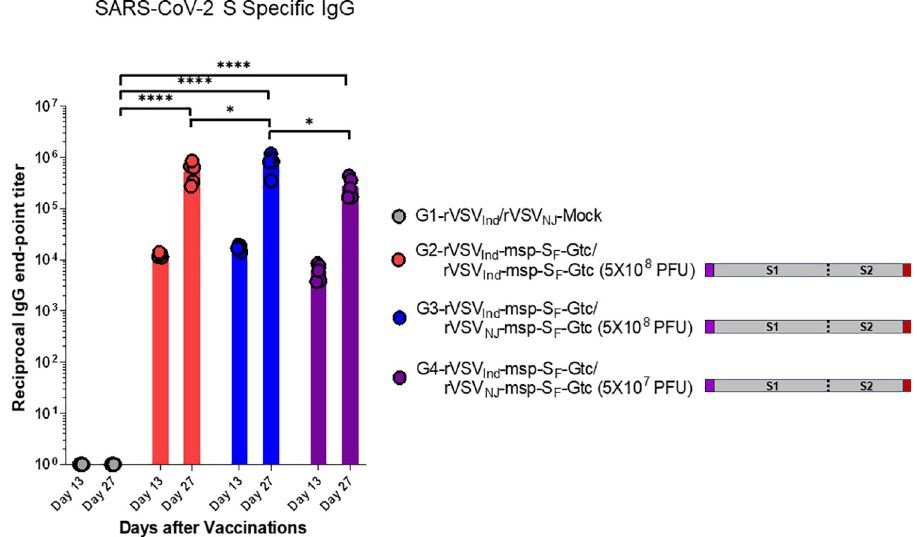
Fig 7. Prime-boost vaccination of hACE2 transgenic mice with rVSV-msp-S F -Gtc induces a high level of Spike ( Δ TM) specific IgG. Six-week-old female hACE2 transgenic mice were prime vaccinated with rVSV Ind -msp-S F -Gtc and boost vaccinated with rVSV Ind -msp-S F -Gtc or rVSV NJ -msp-S F -Gtc two weeks after the prime-vaccination. Serum was collected to determine the SARS-CoV-2 Spike( Δ TM) protein-specific antibody level by ELISA on day 13, one day before the boost-vaccination and on day 27, two weeks after the boost-vaccination. Statistical significance was determined by two-way ANOVA with Tukey’s correction ( � , p < 0.05; �� , p < 0.005, ��� , p < 0.001, ���� , p < 0.0001; ns, not significant). The data were presented as means with error bars of standard deviation (n = 5 mice per group). Purple box: honeybee msp, red box: VSV Gtc. VSV-Mock denotes VSV vector alone without any gene insert.